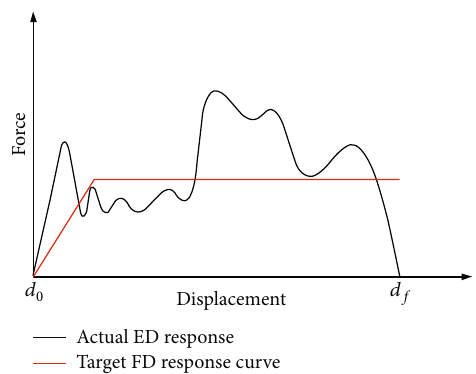
Figure 1: FD response of thin-walled structures under impact loading.